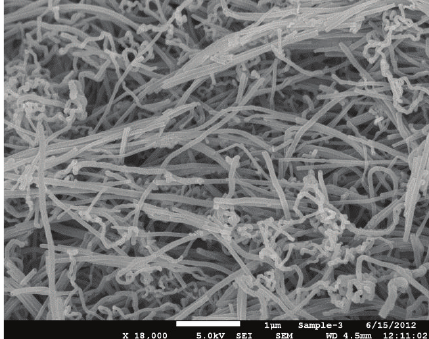
Figure 2: Scanning electron microscope image of oxidized carbon nanofiber.